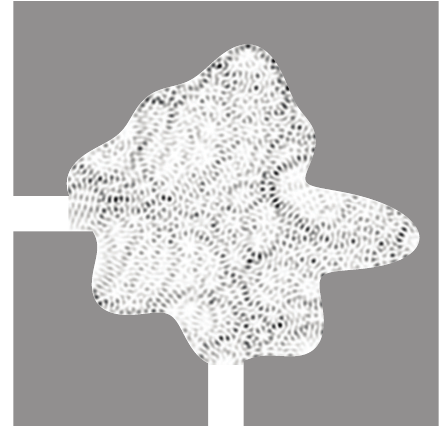
Figure 16: A contour plot of an electron density in a sample dot for √ 150 π , (cid:4) B = 9, and the fundamental mode Kd =